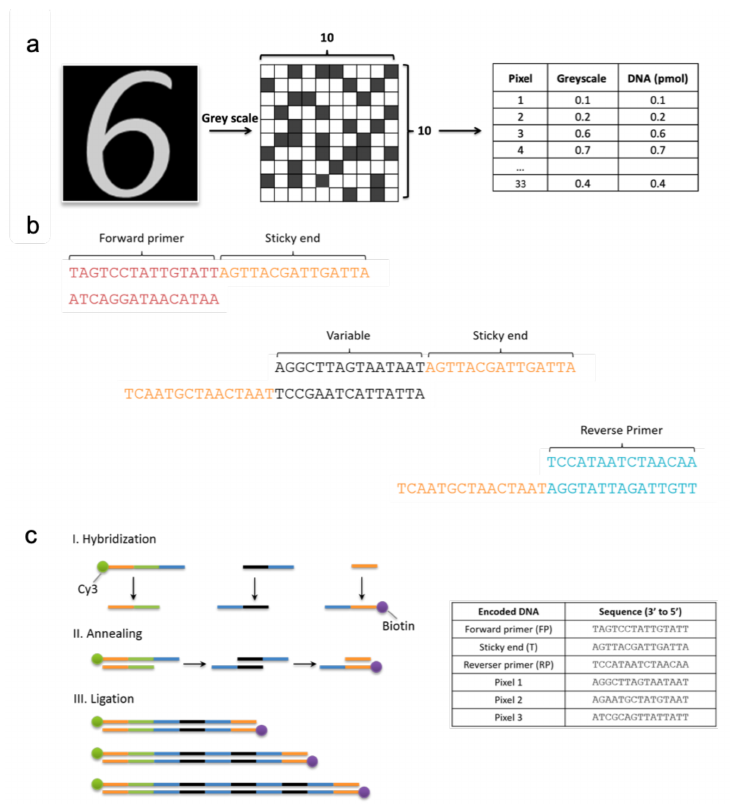
Figure 4. Encoding images to DNA hyperedges ( a ). Encoding of image data to unique DNA sequences ( b ). Complementary DNA sequences of primers, sticky ends and variable DNA that are ligated to form hyperedges ( c ). Self-assembling of free-order hyperedges through three processes, hybridization, annealing, and ligation. Key: Primers (orange), class label (green), tag or sticky end (blue), pixel (black). Please note, the pixel DNA colored black represent unique DNA sequences of various pixels, but for simplicity have been colored black to group them as variable DNA. Table shows DNA sequences for encoded pixels, primers and sticky ends. The final double strands in the sample are separated to single stranded DNA for use as the random DNA library